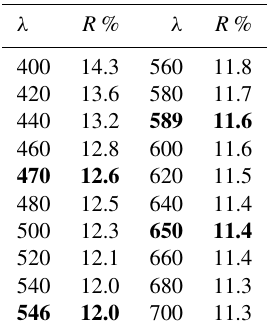
Table 1. Reflectance data for monteneveite. Interpolated values for COM (Commission of Ore Minerals) wavelengths are given in